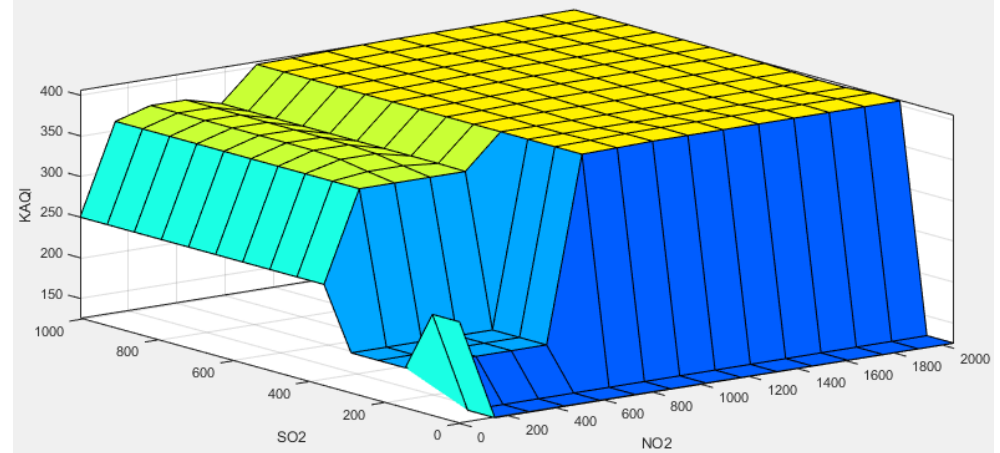
Figure 10. Surface view of the KAQI in Fuzzy Inference